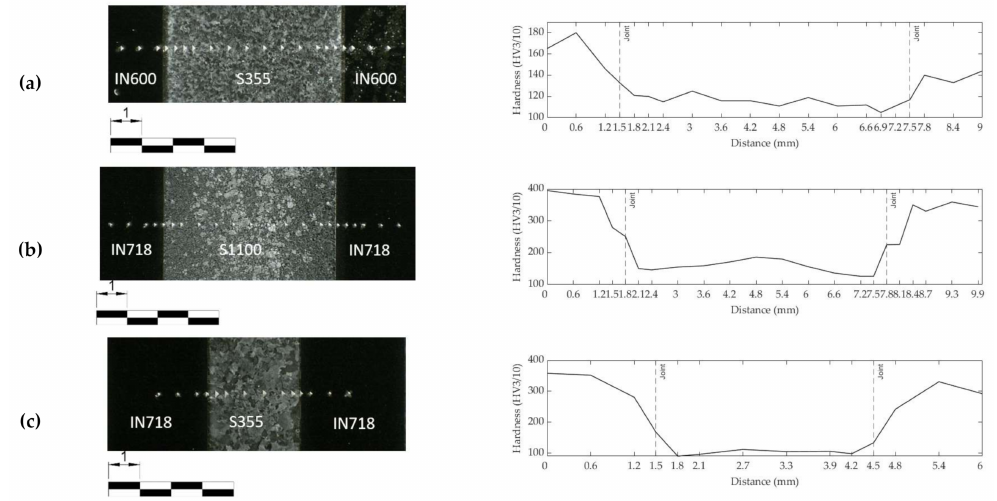
Figure 6. Macroscopic structure of the joints and microhardness (HV3/10): ( a ) S355-IN600 vacuum brazed; ( b ) S1100-IN718 HIP; and ( c ) S355-IN718